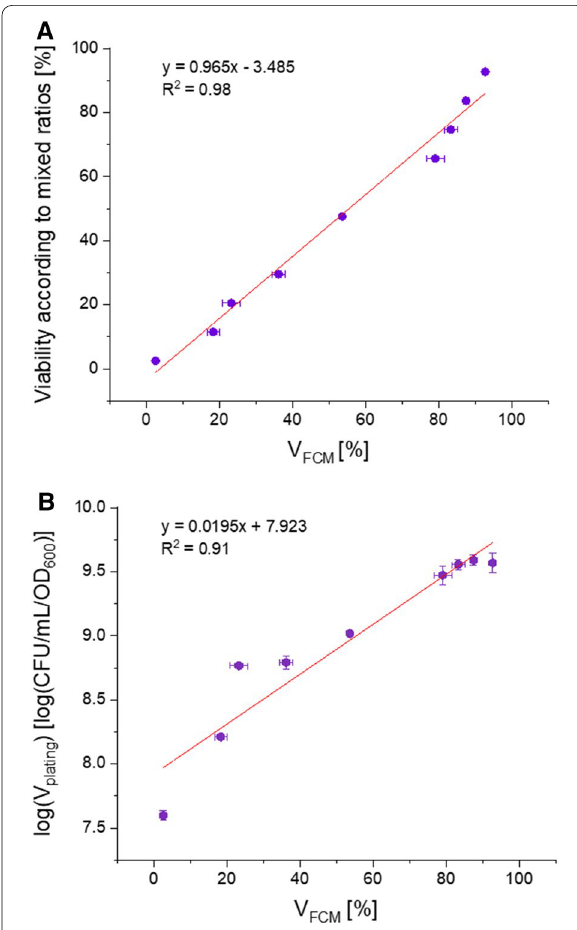
Fig. 2 A Sensitivity analysis of viability according to mixed ratios [%] vs. V FCM [%]. Viability according to mixed ratios [%] were obtained by mixing different ratios of non-viable and viable cell populations. V FCM cells [%] were measured by the flow cytometer and evaluated according to Fig. 1. B Comparison of state-of-the-art method log[V plating (CFU/mL/OD 600 )] versus V FCM